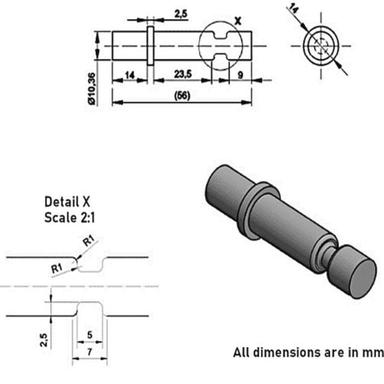
Graphite connector.